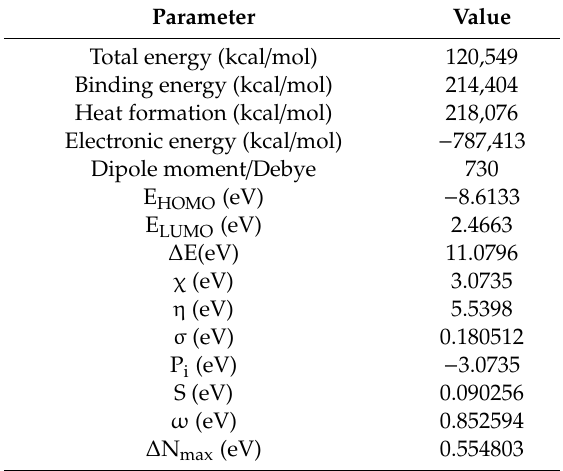
Table 7. The quantum chemical parameters of free OFL ligand.